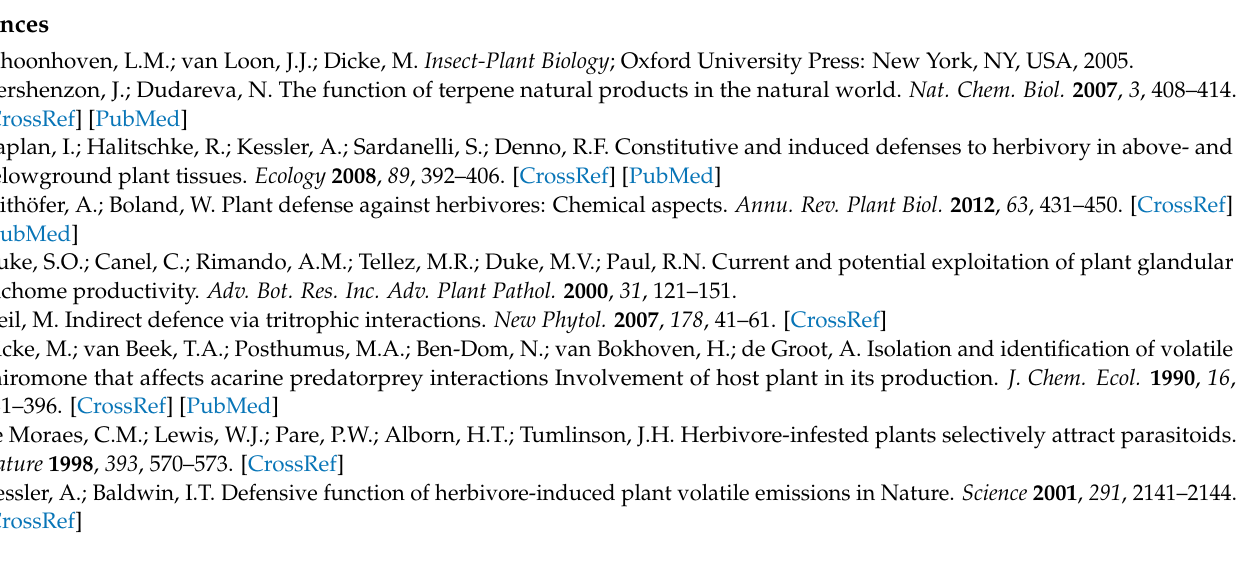
Figure S2: A picture showing the position of an adult when it just reached the score point in the Y-olfactometer